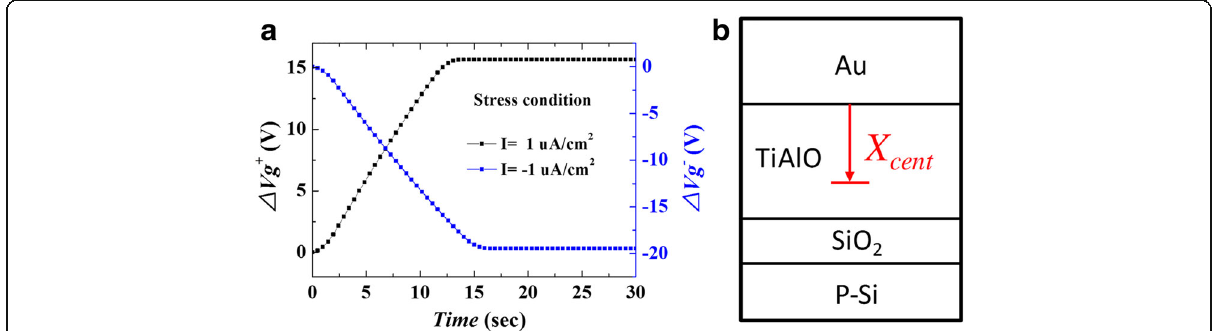
Fig. 6 ( Color online ) a Charge-trapping characteristics of the Au/TiAlO/SiO 2 /Si structure under constant current stress of 1 μ A/cm 2 . b A schematic diagram of the charge trap centroid ( X cent ) of the TiAlO